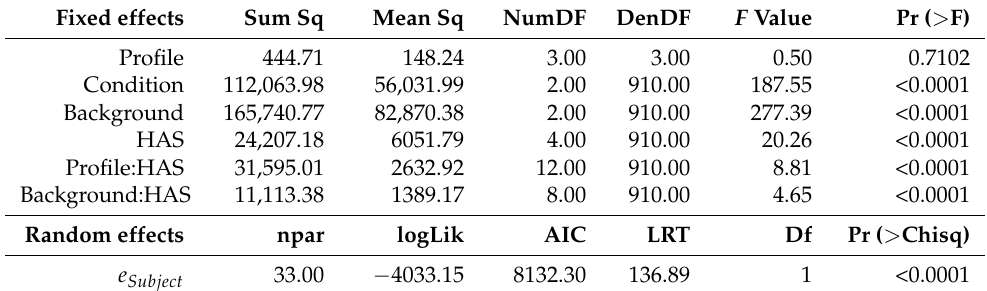
Table A1. Analysis of variance of the linear mixed model used in the data